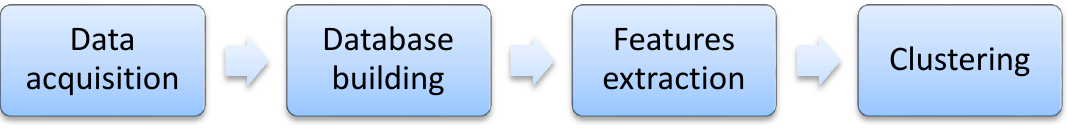
Figure 1. Flowchart of the proposed damage detection approach.